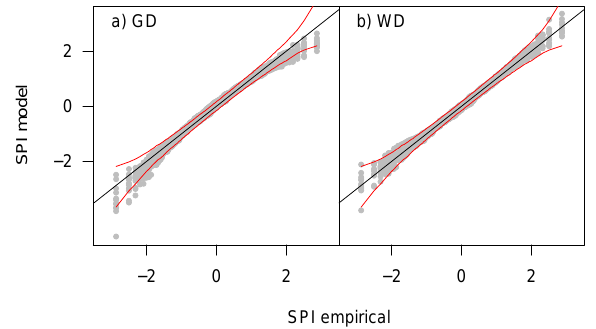
Fig. 4. Differences to the expected probabilities of the SPI classes in percent for England and Wales precipitation. SPI time series are calculated with (a) GD, (b) WD, (c) BD, (d) EWD and (e) GGD.